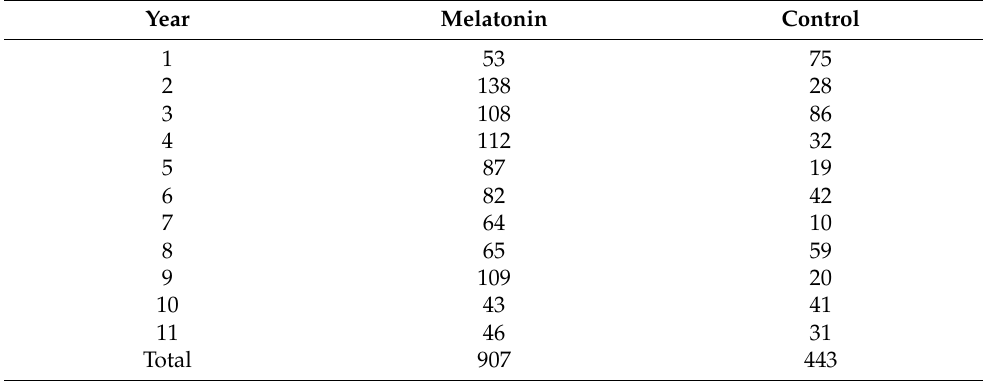
Table 1. Distribution of the sample size across the years of